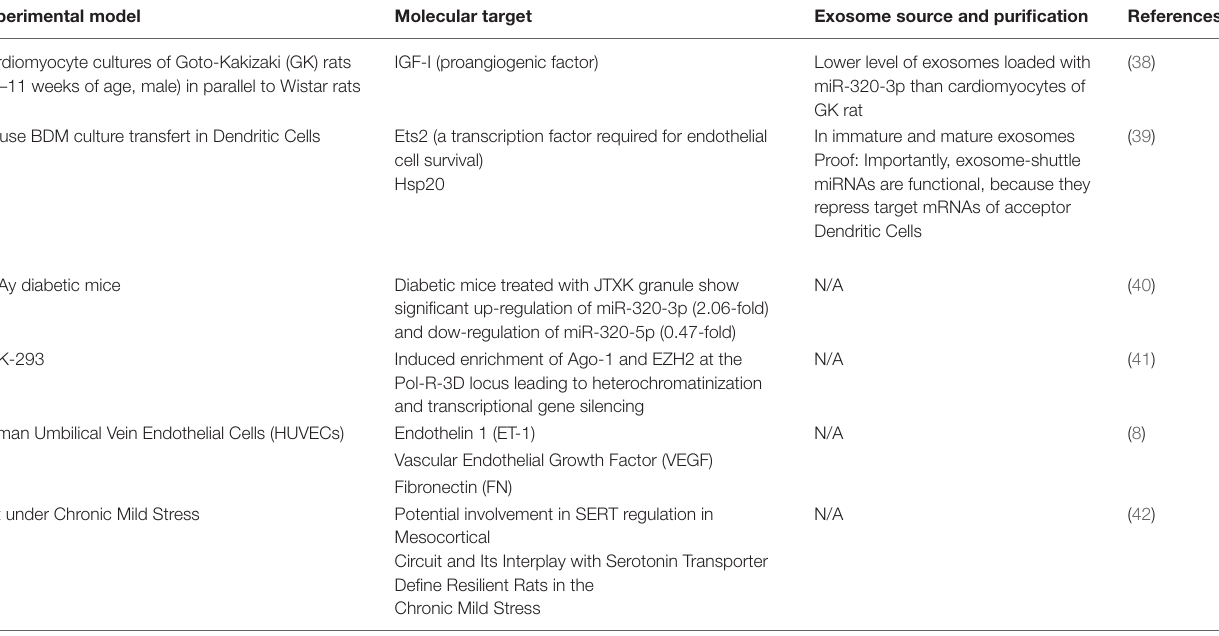
TABLE 1 | Known molecular targets of miR-320-3p and relation with exosomes in rodent models. Experimental